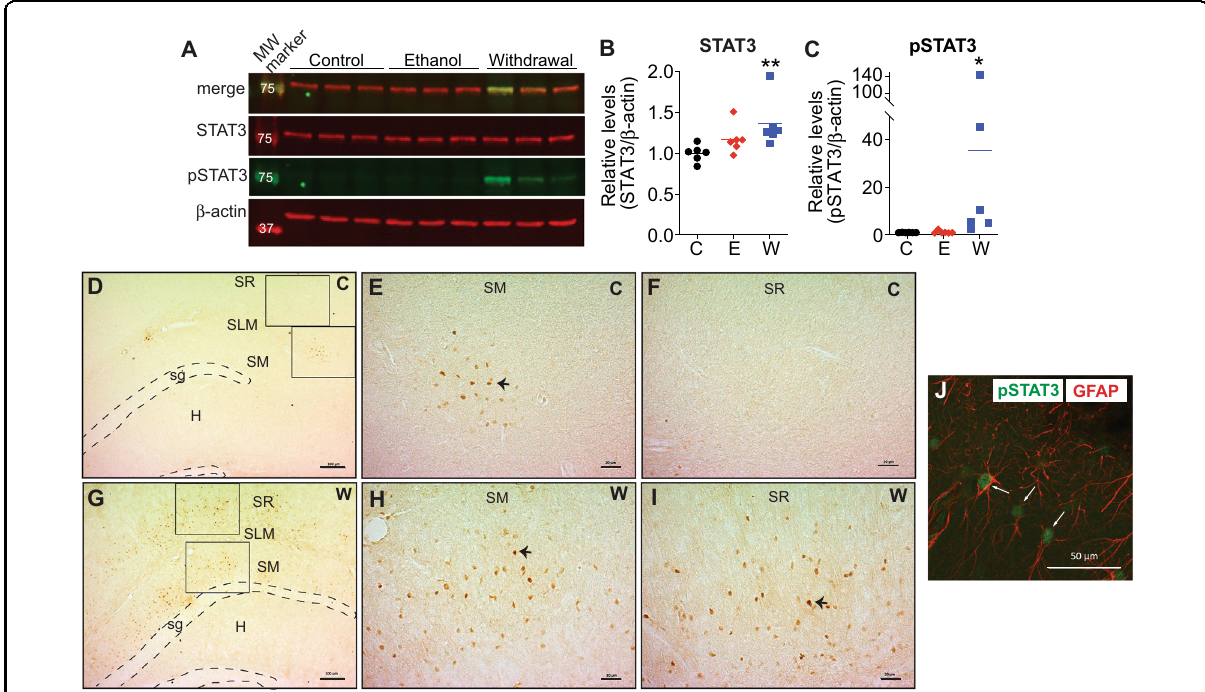
Fig. 2 Increased total and phosphorylated STAT3 protein in the hippocampus of ethanol withdrawn rats after chronic exposure. Rats were fed control liquid diet (C), ethanol liquid diet (E), or ethanol liquid diet followed by 24 h of withdrawal from ethanol diet (W). The dorsal hippocampus was either ( A – C ) dissected and protein lysates analyzed by western blot ( n = 6 per group) or ( D – J ) processed for immunohistochemistry ( n = 3 per group). A Representative western blot showing (top to bottom) merged image of phosphorylated (p)STAT3 and STAT3, STAT3 (red), pSTAT3 (green), and β -actin (red). Molecular weight markers are indicated in kDa. B Levels of STAT3 relative to β -actin. C Levels of pSTAT3 relative to β -actin. Data are presented as the mean ± SEM. * p < 0.05 and ** p < 0.01 when compared with control by Kruskal – Wallis test after one-way ANOVA. Representative images of hippocampus showing pSTAT3-positive cells in brown in ( D – F ) control and ( G – I ) ethanol withdrawn rats. Panels ( D ) and ( G ) are images at ×5 magni fi cation with a scale bar representing 100 μ m. Boxes show areas that are magni fi ed in ( E – F ) and ( H – I ), with scale bar representing 50 μ m. sg stratum granulosum, SM stratum moleculare, SLM stratum lacunosum moleculare, SR stratum radiatum, H hilus. J Representative immuno fl uorescent image of pSTAT3 in green, colocalized with the astrocytic marker glial fi brillary acidic protein (GFAP) in red. White arrows show localization of pSTAT3 in a GFAP-expressing cell. Scale bar, 50 μ